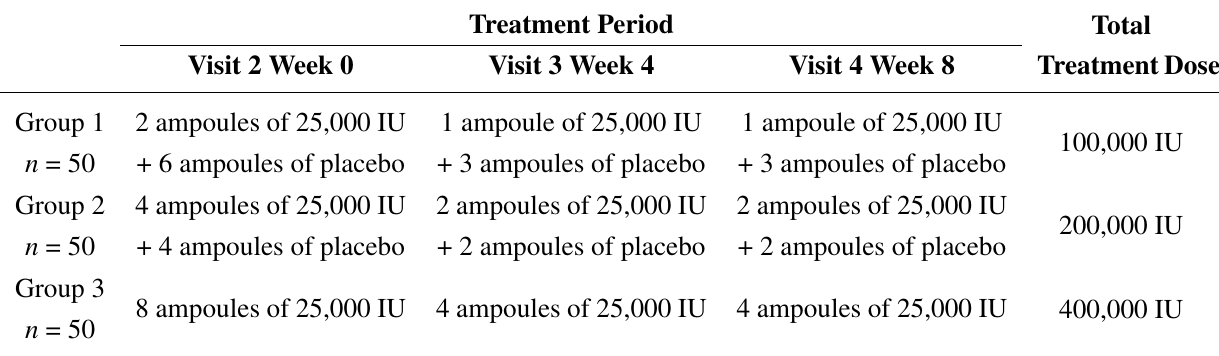
Table 1. Treatment scheme with different intakes of vitamin D (VTD3) according to randomization